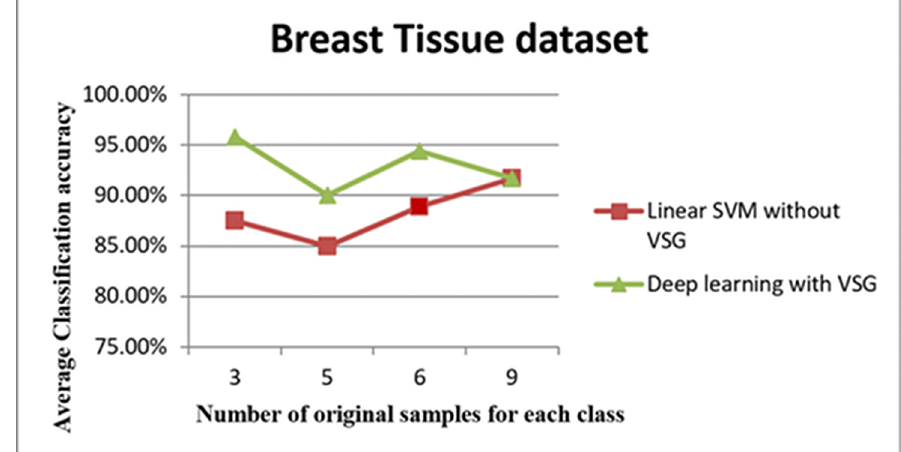
Figure 12. The trend of the average accuracy using the Breast Tissue dataset. The x -axis of this graph shows the original samples for each class that were used to generate the virtual sample in deep learning and the training sample for linear SVM, while the average of classification accuracy is the y